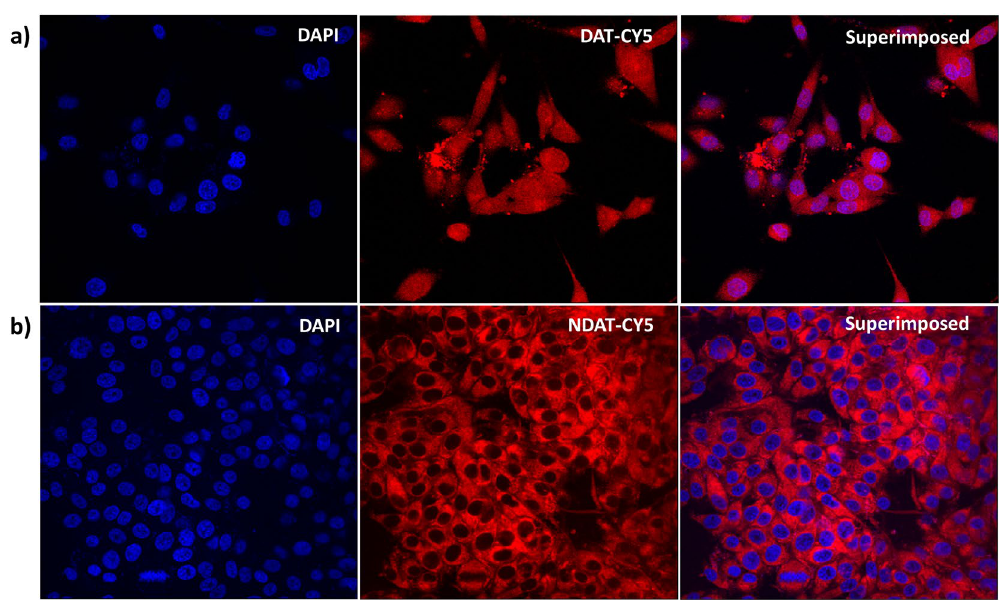
Figure 5. Confocal microscopy images of U87 cells incubated for 4 hours with Cy5 dye-labelled DAT ( a ) and NDAT ( b ). DAT reached the nucleus, and NDAT was restricted from going inside the nucleus. Cells were counter-stained with DAPI (4 ′ ,6-diamidino-2-phenylindole) to visualize the nuclei: blue for DAPI and red for Cy5. Magnification,